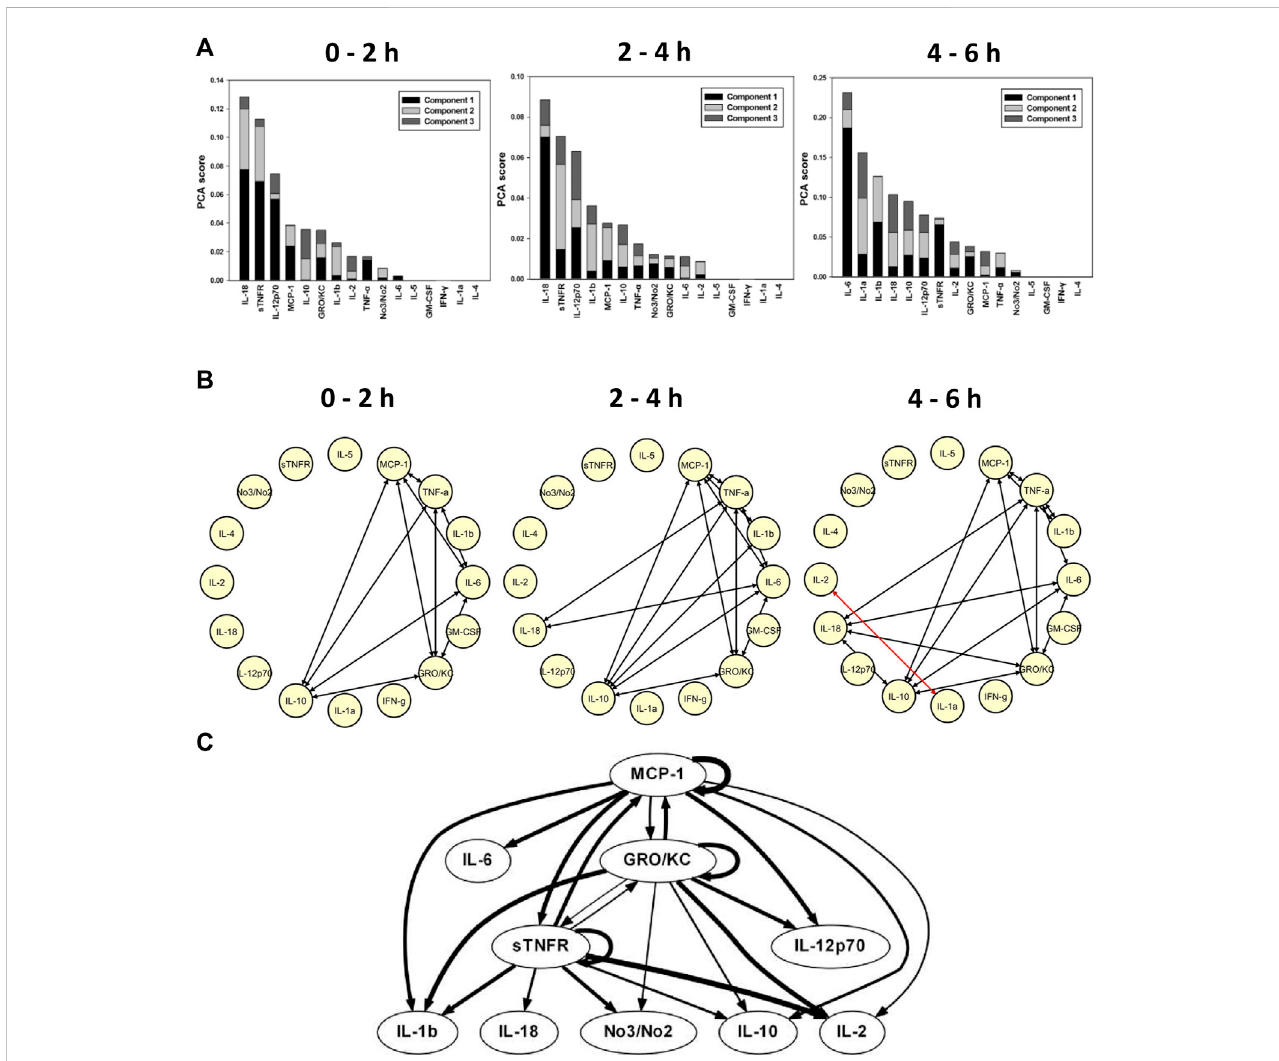
Constitutively delivered sTNFR reprograms systemic in fl ammation induced by E. coli --impregnated fi brin clot peritonitis (Gram--negative sepsis). Rats (n=4)subjectedto E.coli fi brinperitonitisfor24 h(time=0 h)werecannulatedforafurther6 h(totalof30 hofexperimentalsepsis)tobioreactorproducing sTNFR constitutively (CMV--driven). (A) Principal component analysis (PCA)wascarriedout overthree time intervals (0 – 2, 2 – 4,and 4 – 6 h) usingtime course data of circulating in fl ammatory mediators. PCA pointed to a differential role of in fl ammatory mediators that characterizes the in fl ammatory response over the three time intervals. (B) Dynamic network analysis (DyNA) of circulating in fl ammatory mediators was performed during three time frames, 0 – 2, 2 – 4, and 4 – 6 h, as described in Materials and Methods. In fl ammatory mediators encircled with a red circle represent mediators (sTNFR and IL--12p70) that were statistically signi fi cantly altered by One--way ANOVA ( p < 0.05) with at least one connection to another mediator. (C) Dynamic Bayesian Network (DyBN) inferenceofthein fl ammatorymediatorsoverthe6 hstudyperiodsuggested thatcentralnodesconsistedoftheMCP--1,GRO/KC, andsTNFR.Thethickness of each arrow denotes the relative algorithmic con fi dence in a given interaction between